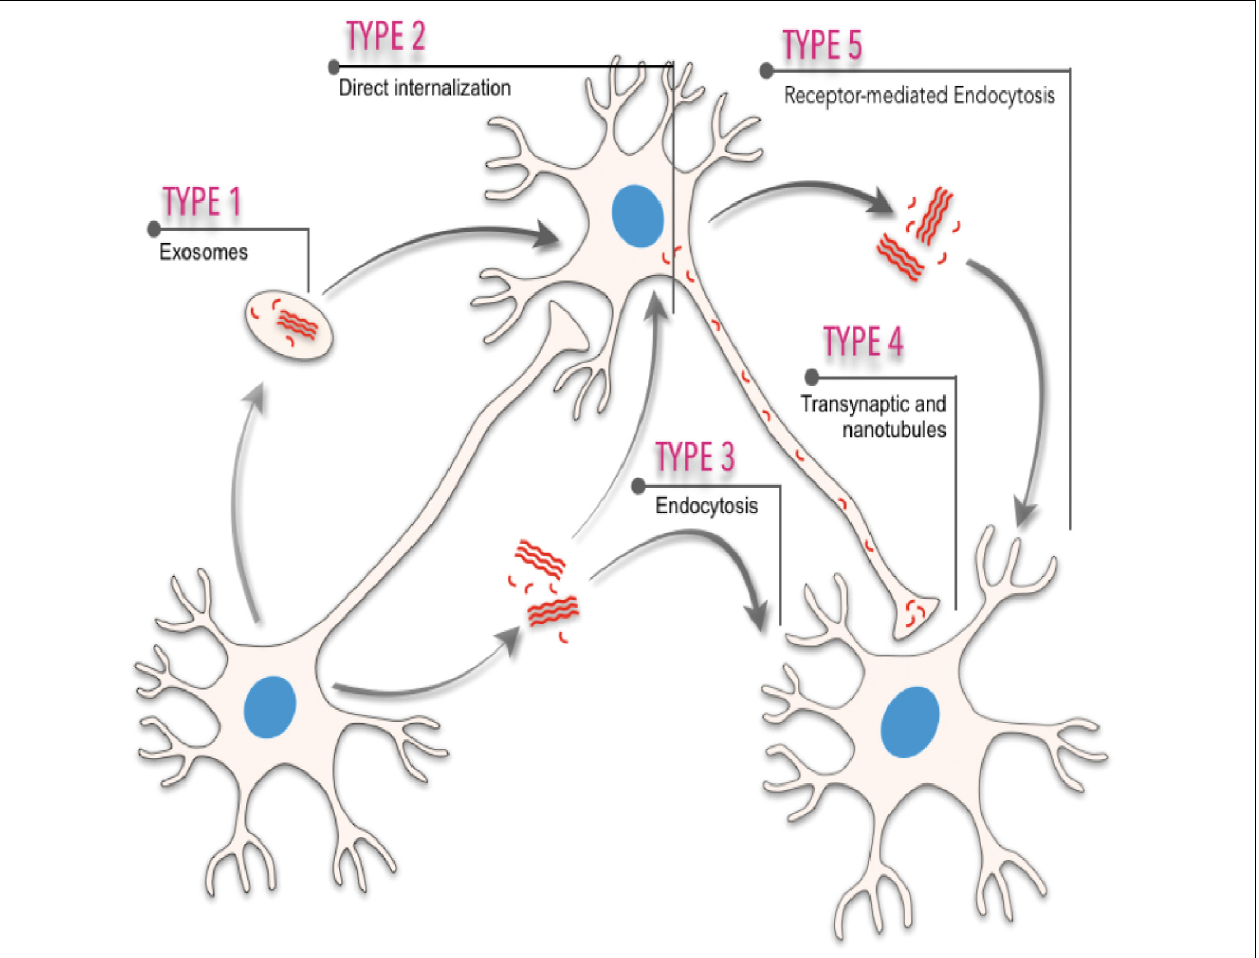
FIGURE 1 | Scheme illustrating the different spreading pathways of a “hypothetical” pathogenic seed between different cells. Five different means of transmission are illustrated: (i) from exosomes or multivesicular bodies, (ii) direct internalization by interacting with plasma membranes, (iii) endocytosis or micropinocytosis processes, (iv) transsynaptic transmission and tunneling nanotubules, and (v) receptor-mediated uptake of the